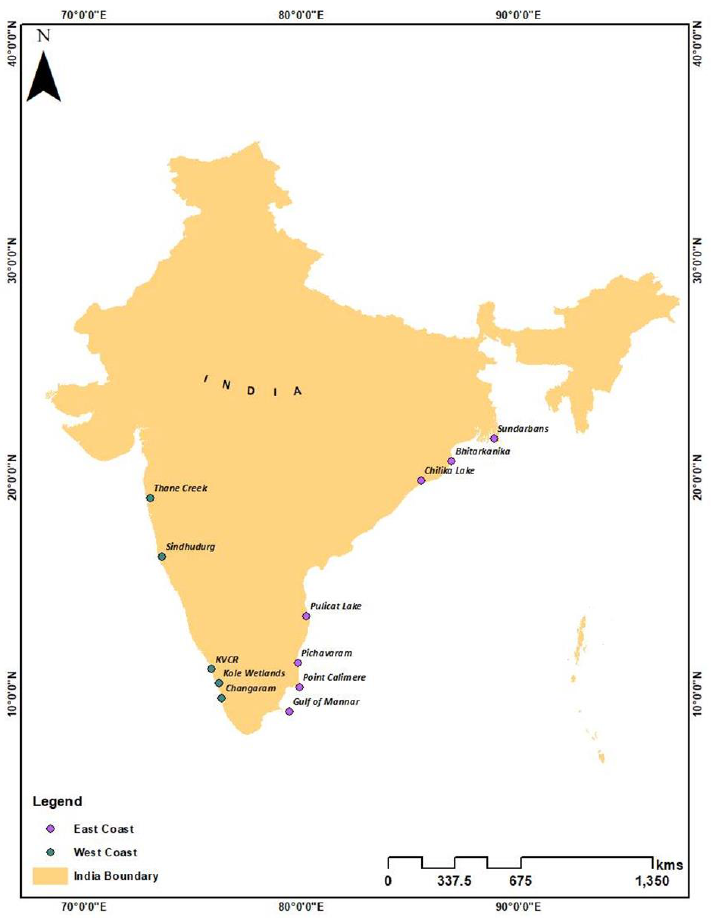
Figure 1. Map showing that major study conducted on shorebirds at west and east coasts of India.